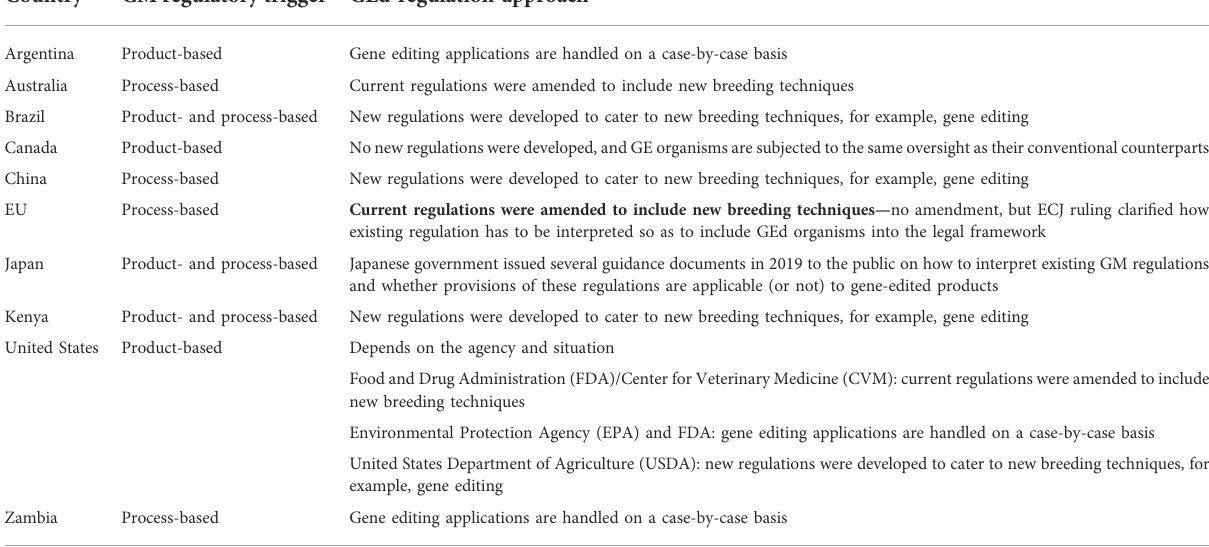
TABLE 1 Summary of current country approaches to both GM and GEd technology regulation.